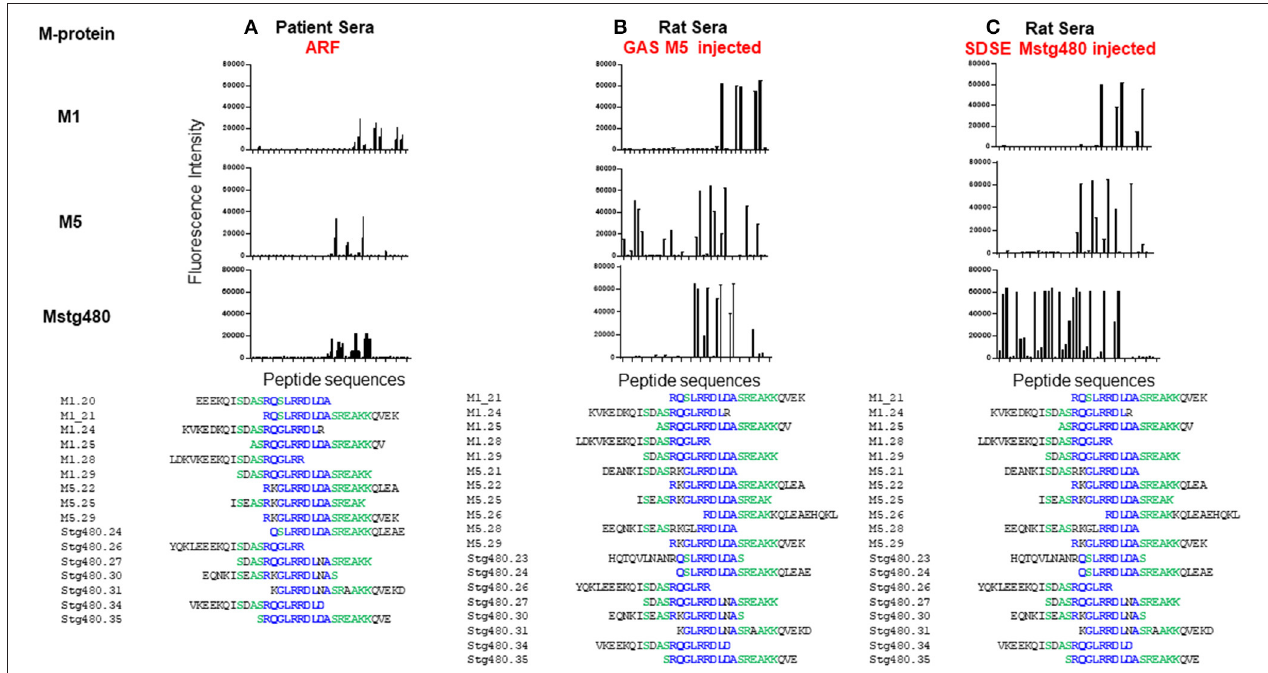
FIGURE 2 | Antibody reactivity with peptides from streptococcal M protein. Fluorescence intensity (RFI) of peptides screened with; (A) pooled human sera from patients with ARF ( n = 7), (B) pooled sera from rats following five injections of GAS M5 ( n = 3), and (C) pooled sera from rats following five injections of SDSE Mstg480 ( n = 3). Rat serum samples were collected 224 days following initial injections. Peptide microarrays consisting of 186 overlapping 20 mer peptides derived from M1, M4, M5, and Stg480 M-proteins were constructed by JPT technologies. Sera samples were diluted in blocking buffer (1:200) and incubated with the